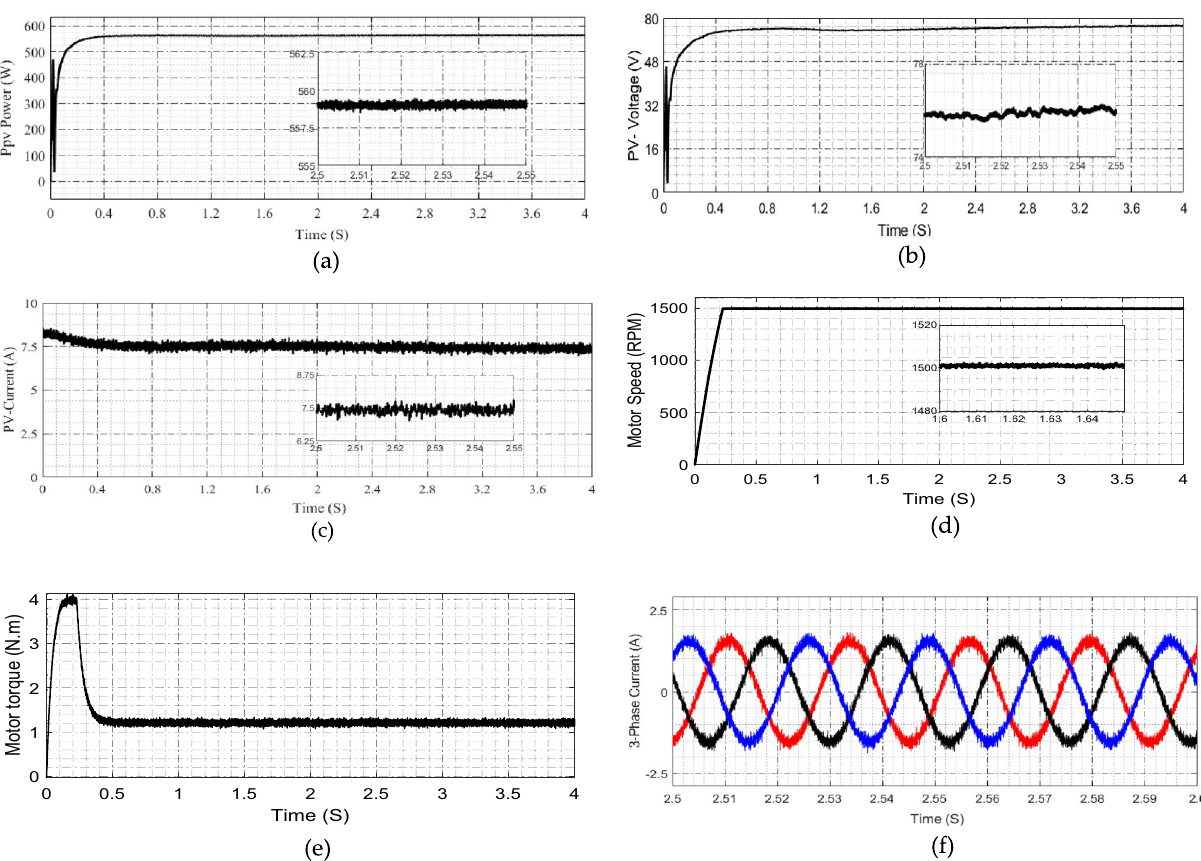
Figure 12. Experimental results at Irradiation 800 W/m 2 ( a ) PV-power ( b ) PV-voltage ( c ) PV-current ( d ) voltage after high gain cell motor speed ( e ) motor torque ( f ) Motor phase